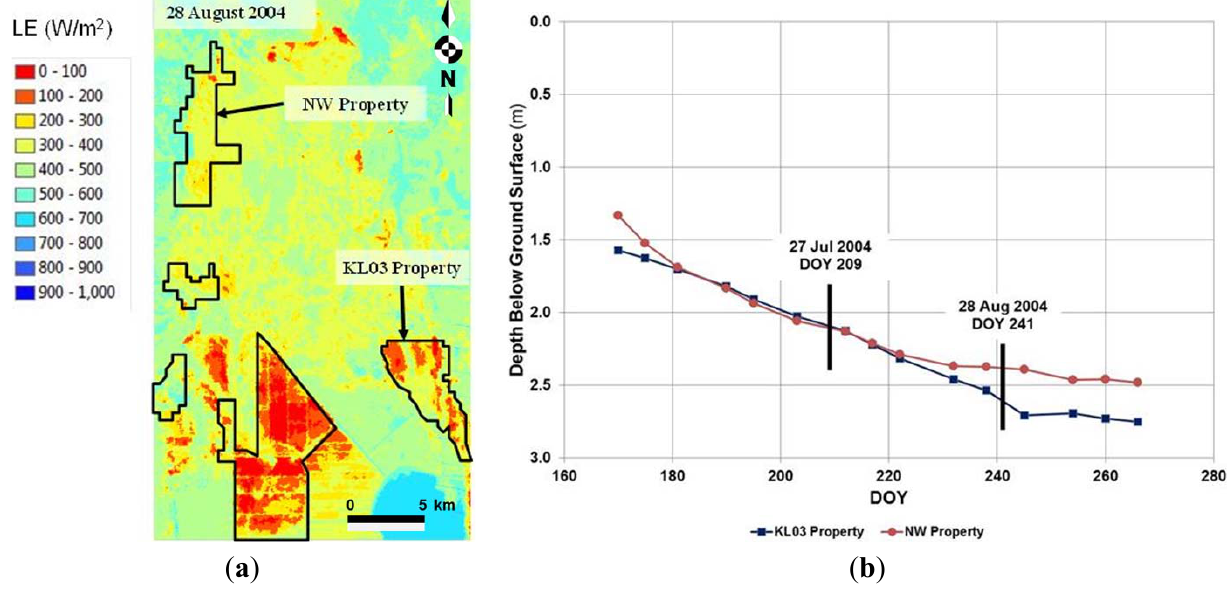
Figure 12. ( a ) Location of NW property with unexpected levels of ET from Landsat analysis; ( b ) depth below ground surface of shallow groundwater at KL03 and the NW property during summer 2004.